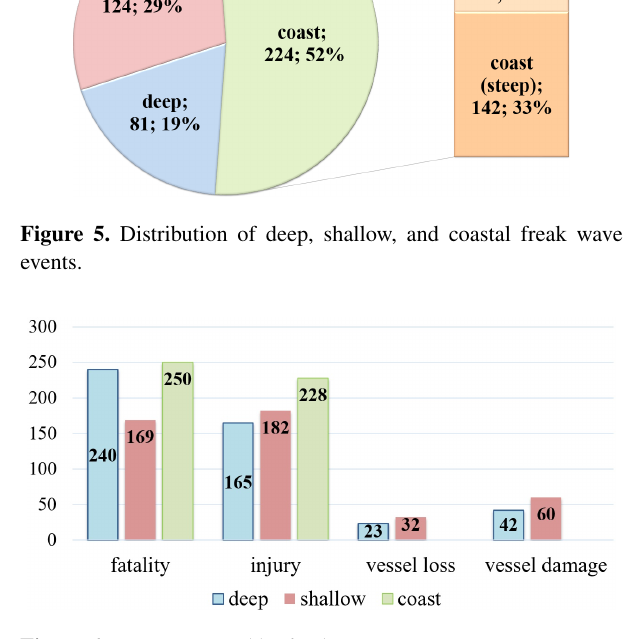
Figure 4. Freak wave accident on Mavericks Beach on 13 Febru- ary 2010 (© Scott Anderson).